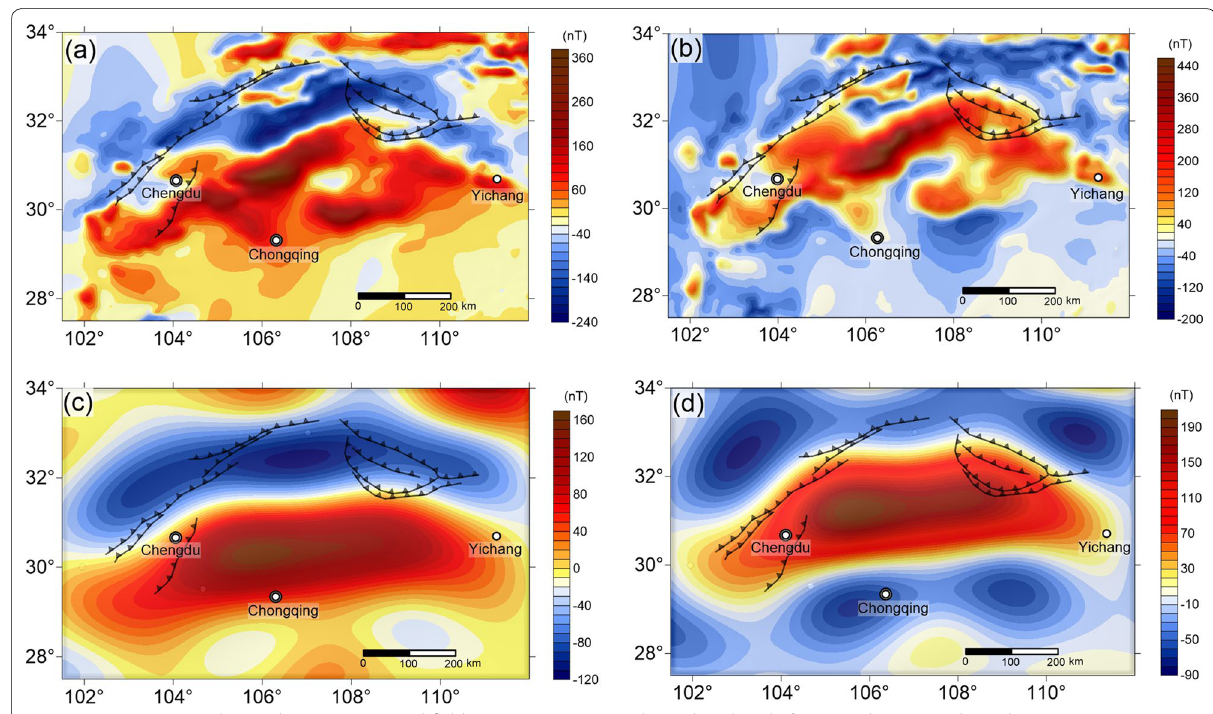
Fig. 2 Magnetic anomaly in Sichuan Basin. a Total-field aeromagnetic anomaly at 4 km altitude. b RTP (reduction-to-the-pole) aeromagnetic anomaly at 4 km altitude. c Total-field long-wavelength magnetic anomaly. The data are from the MF7 model using CHAMP satellite measurements and compiled at WGS-84 ellipsoid altitude. It could be downloaded from the website http://geoma g.color ado.edu/magne tic-field -model -mf7.html. d RTP long-wavelength magnetic anomaly. The main thrust faults have been overlaid to each magnetic